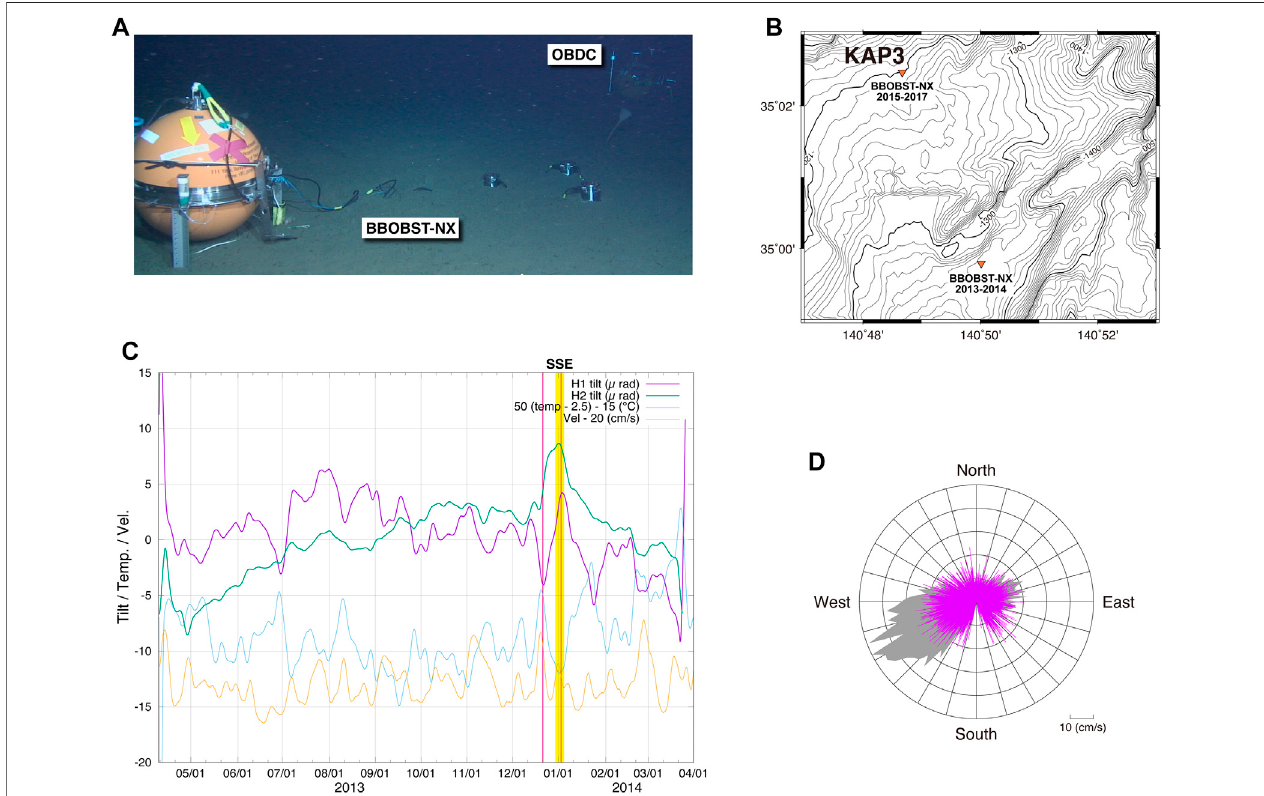
FIGURE 7 | The fi rst feasibility test off the Boso Peninsula. The fi rst long-term observation of the BBOBST-NX was performed at the source area of the SSE with 3 – 4 years intervals. (A) The BBOBST-NX and the OBDC deployed in April 2013 for 1 years-long observation. (B) The location map of two sites in 2013 – 2014 and 2015 – 2017 (recovered in October 2020). The former site was near the cliff with an NE-SW strike. (C) Results of this test observation. In December 28, 2013 – January 4, 2014 (yellow rectangle), the SSE was detected (Ozawa, 2014). The data were processed as in Figure 6C , after removing the steps at mass centering operations. Two purple vertical lines show two earthquakes mentioned in SSE Estimations (D) The rose histogram (normalized) of the bottom current direction (gray shade) and the current velocity (purple) from the 1 h averaged OBDC data. In spite of the surface current by Kuroshio, the dominant current direction was toward N245 ° E, similar to the sea fl oor topography